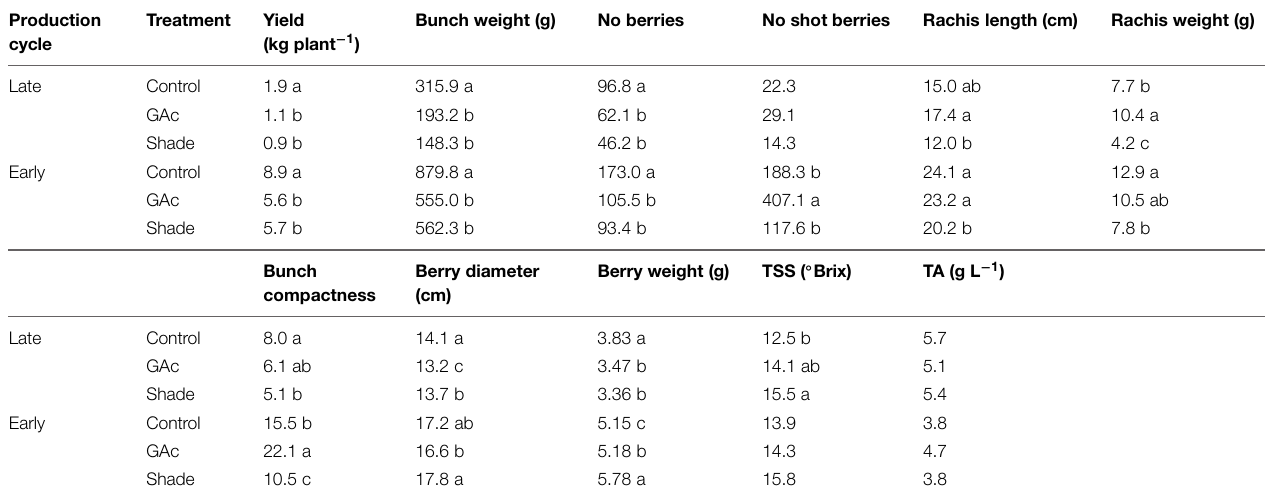
TABLE 2 | Effect of shade and GAc treatments on bunch and berries characteristics at harvest in Black Magic table grape cultivar in the late and early cycles. Production